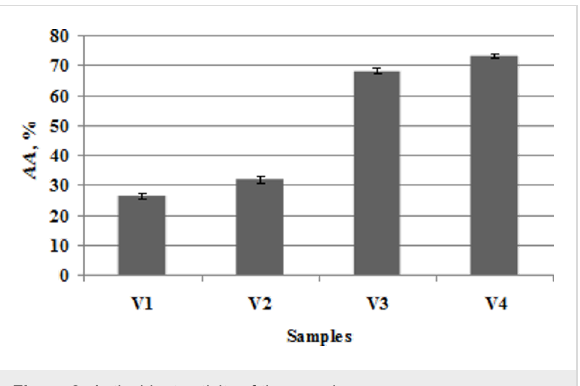
Figure 8: Antioxidant activity of the samples.